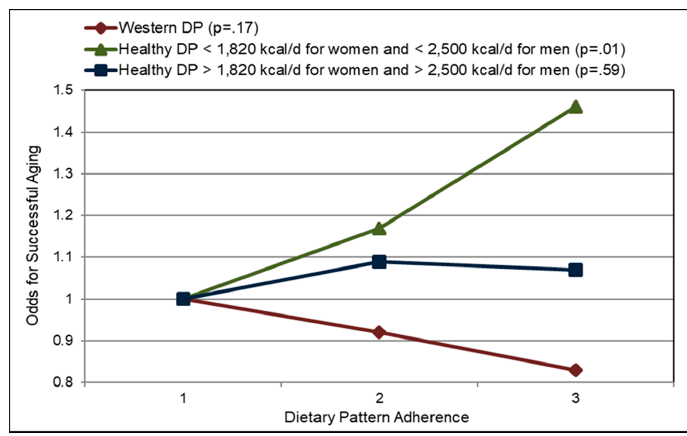
Figure 19. Effects of a healthy dietary pattern (DP) stratified by energy intake level, and the Western DP on the odds for successful aging (multivariate adjusted) [279].